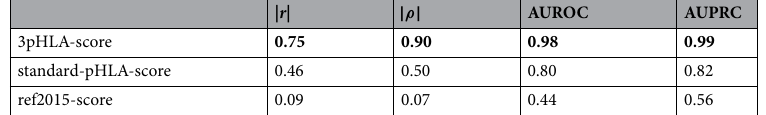
Table 1. Results of scoring functions obtained using different training protocols on the test set averaged across all HLA alleles for all four evaluated metrics (Pearson’s correlation coefficient | r |, Spearman’s correlation coefficient | ρ | , the Area Under the Receiver Operator Curve AUROC and the Area Under the Precision Recall Curve AUPRC) . The highest values and best performing values in each column are